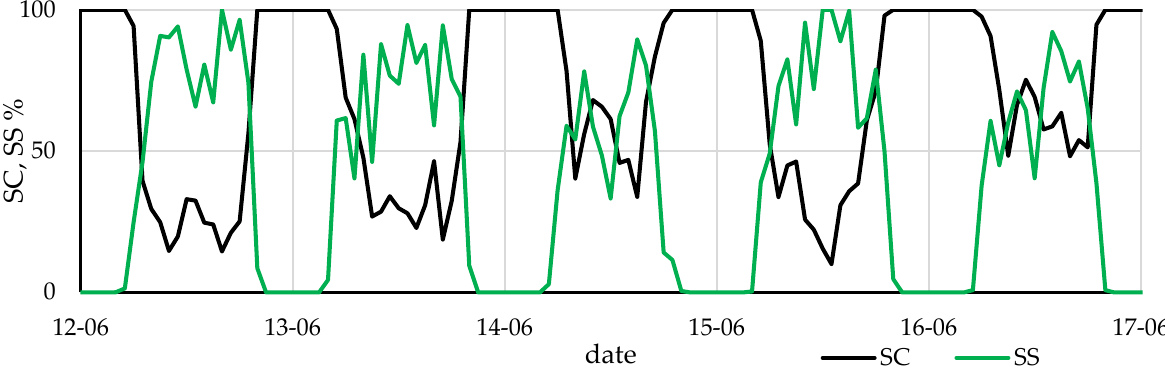
Figure 9. Self-consumption coefficient (SC) and self-sufficiency coefficient (SS) for several days of June 2020.